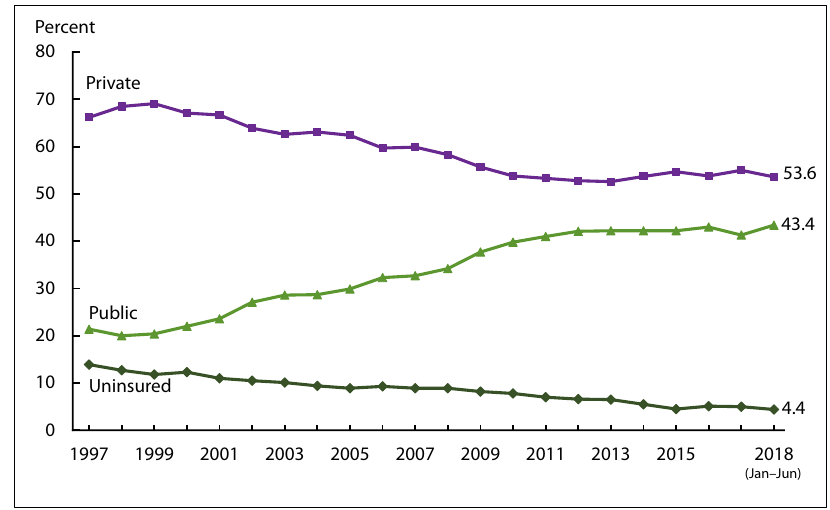
Figure 2. Percentage of children aged 0–17 years who were uninsured or had private or public coverage at the time of interview: United States, 1997–June 2018